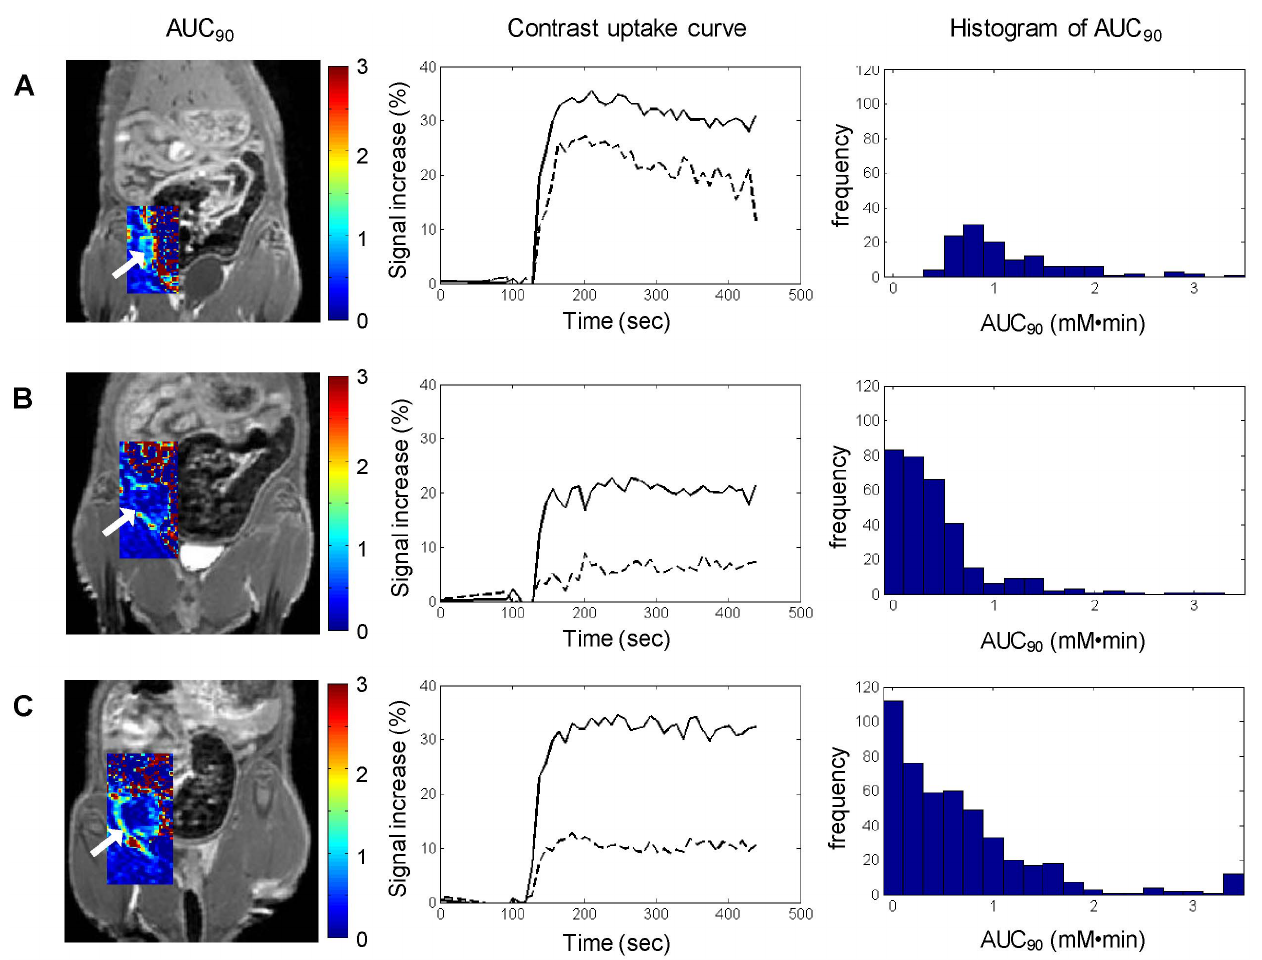
Figure 4. Dynamic contrast-enhanced MRI during tumor progression. (Left column) AUC 90 maps (mM ? min) are overlaid on T 1 -weighted spin-echo images acquired post-contrast injection (A) 6 days, (B) 13 days, and (C) 20 days after cell inoculation in the mammary fat pad. Arrow points to tumor. (Middle column) Corresponding signal enhancement time-course is shown for the tumor rim (solid line) and tumor core (dashed line). (Right column) Corresponding histograms of AUC 90 distributions show an evolution toward lower AUC 90 values.